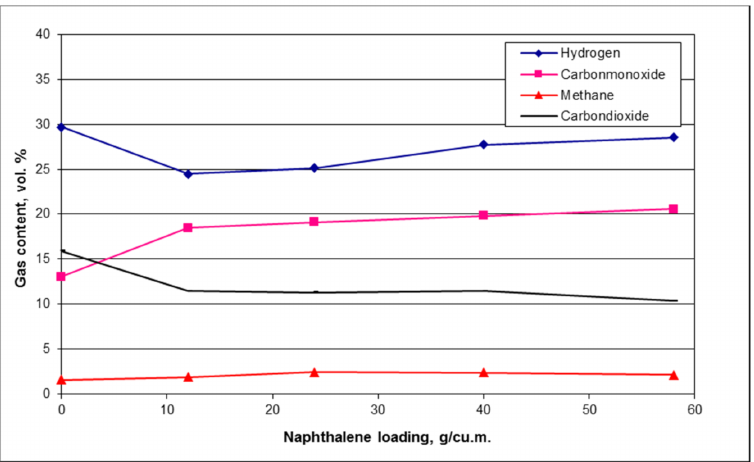
Figure 10. Effect of naphthalene loading on gas composition. Initial gas composition: H 2 (20%), CO (20%), CO 2 (10%), CH 4 (3%) (T—750 ◦ C, GHSV—12,800 h − 1 , S/C—5, catalyst—7.5%